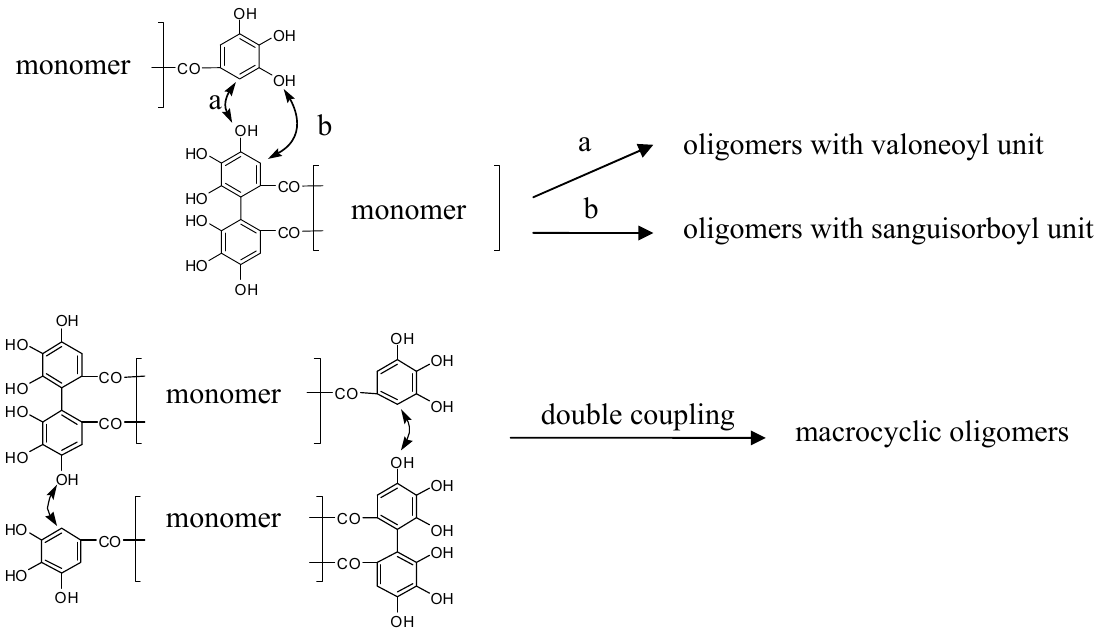
Figure 4. General oligomerization mode for the types 1 and 2. (1) examples of coupling mode for formation of valeoyl or its equivalent unit by C-O coupling. (2) macrocyclic dimer (double coupling for HHDP and galloyl).